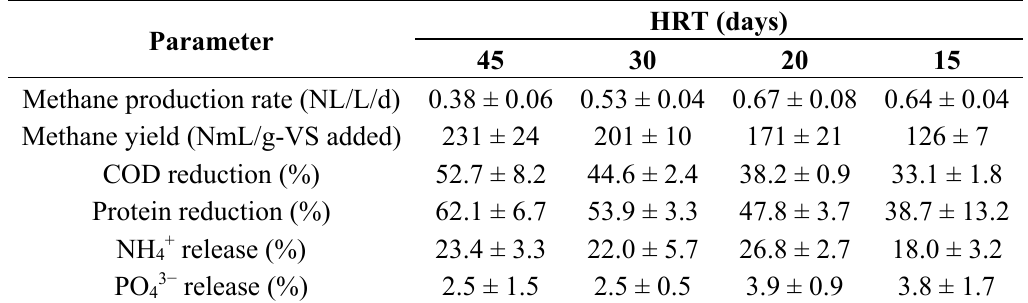
Table 2. Effect of HRT on the degradation characteristics in the semi-continuous